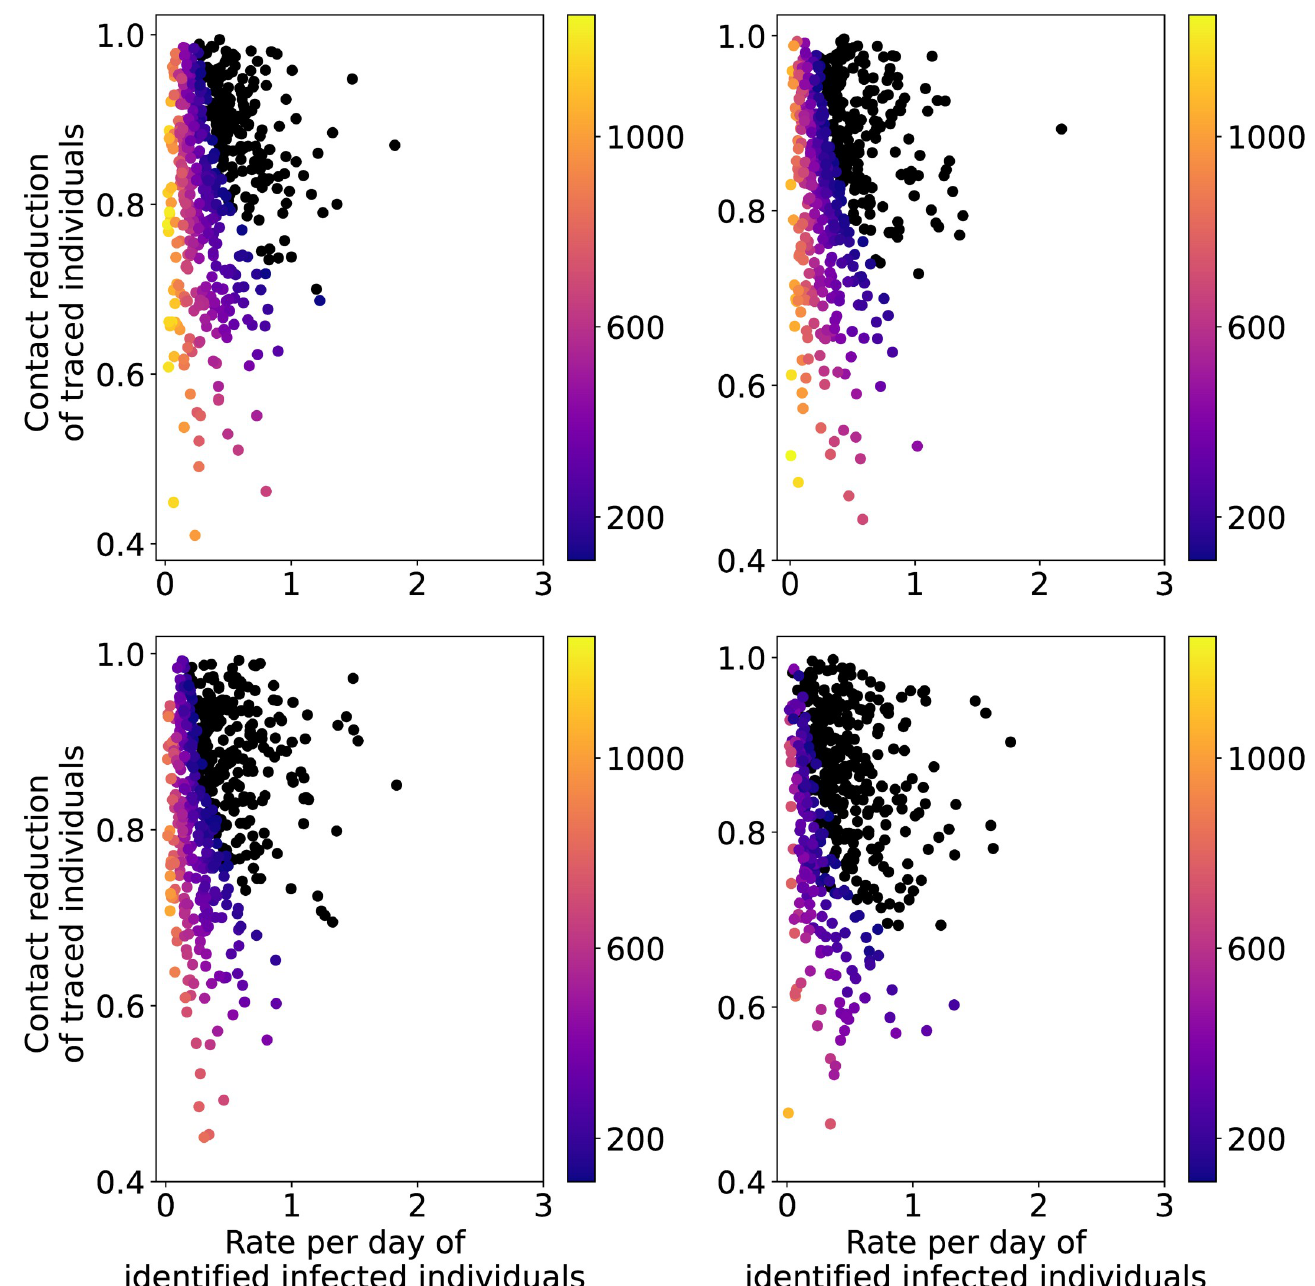
Fig 5. Heat map of the maximum values of patients in IC per million capita as a function of the input parameters for the CT strategy with seed and policy- related uncertainties. The black dots show the simulations whose maximum value is below or equal to the IC capacity. The plots correspond to quartiles of trace_prob_E (top left: very low; top right: low; bottom left: high; bottom right: very high).